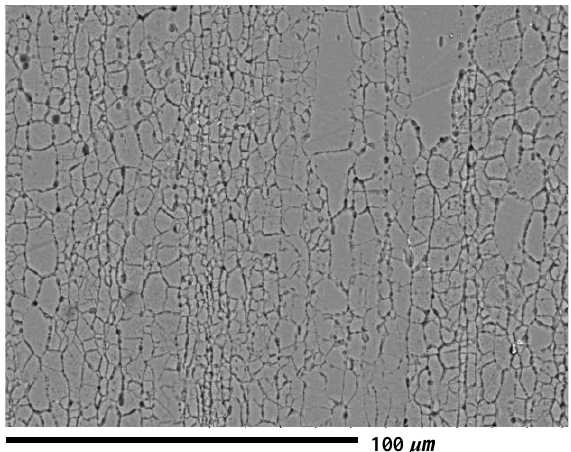
Figure 5. Microstructure of the base material in the rolling direction (untreated condition).